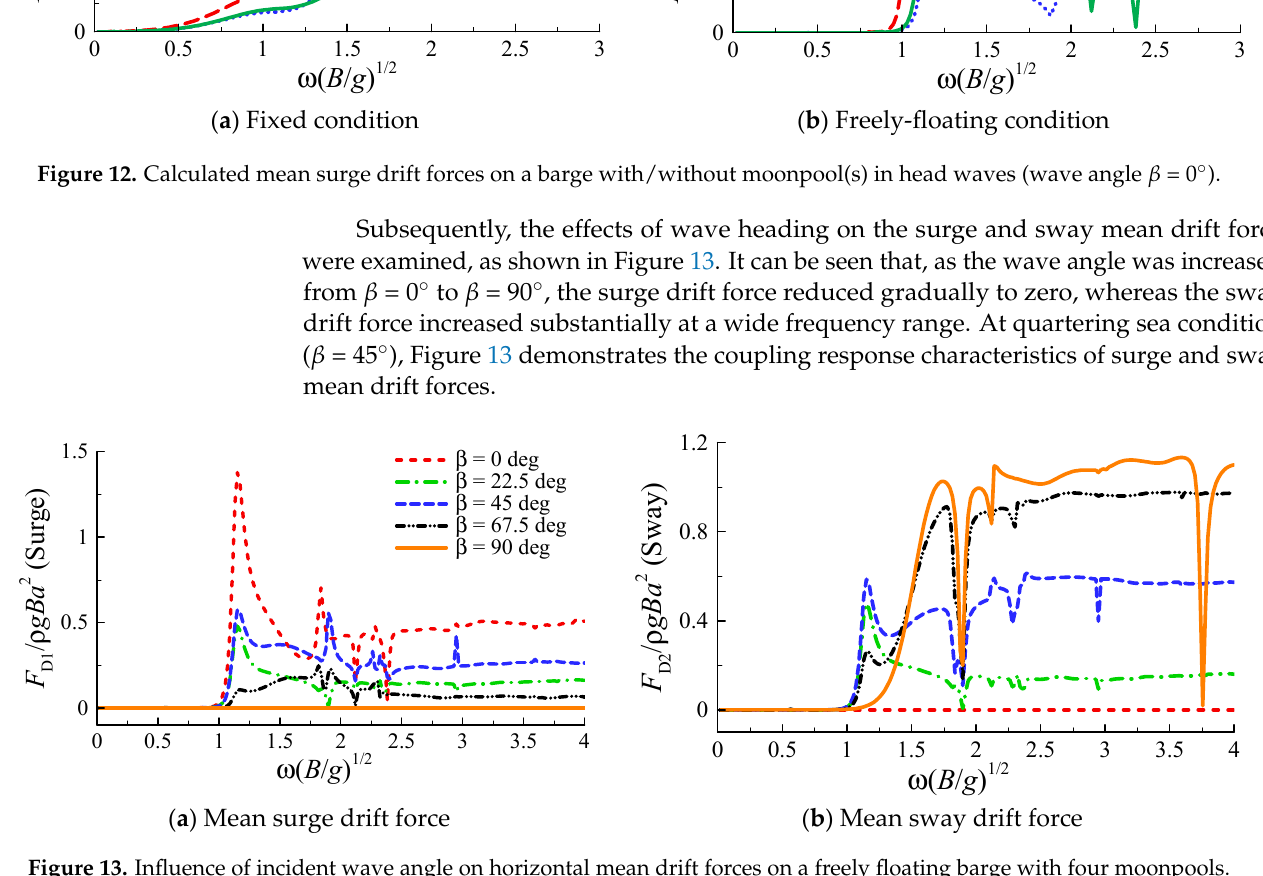
Figure 13. Influence of incident wave angle on horizontal mean drift forces on a freely floating barge with four moonpools.